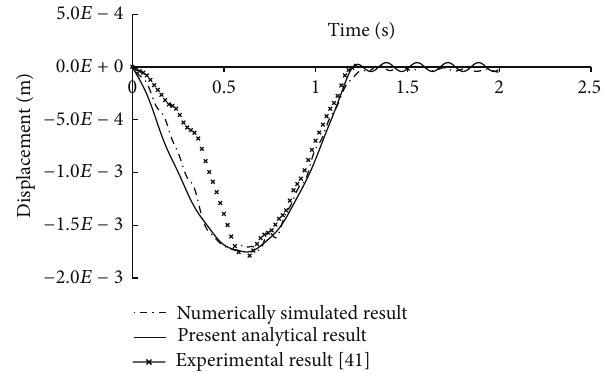
Figure 2: Comparison of analytical, numerical, and experimental